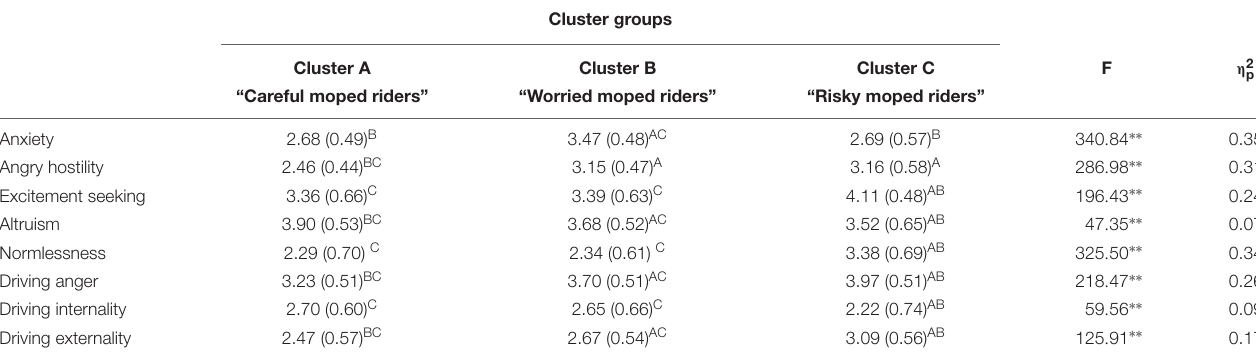
TABLE 2 | Cluster differences on the raw scores of personality (general and specific) measures included in cluster